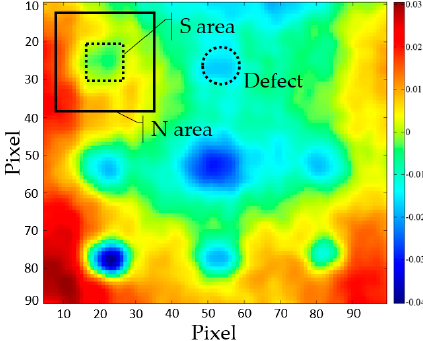
Figure 5. Example of areas for SNR calculation.